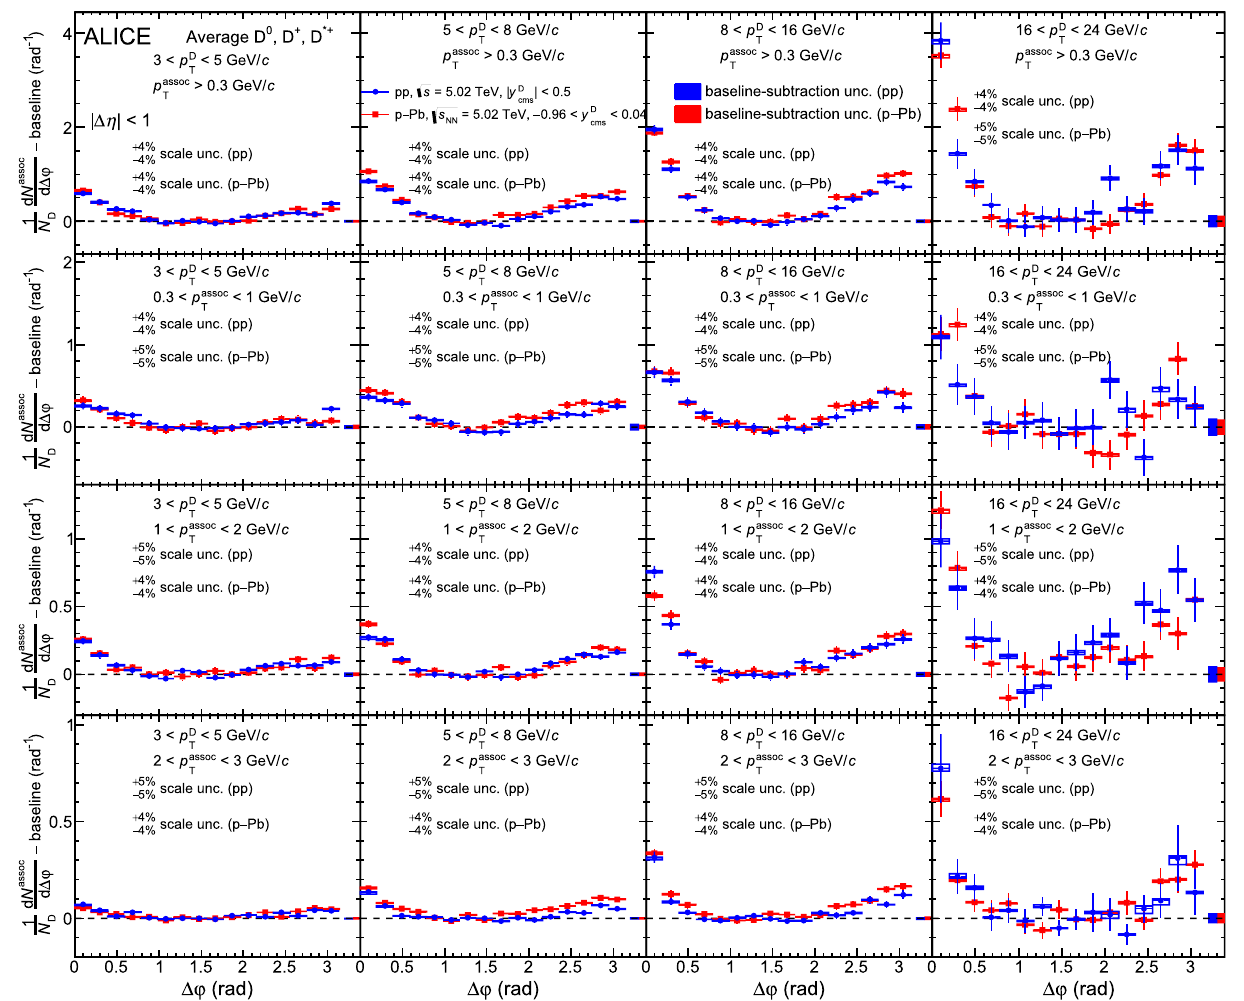
< 3 GeV / c (from top to bottom). Statistical and (cid:4)ϕ - Fig. 3 Average of the azimuthal-correlation functions of D 0 , D + , and and 2 < p assoc T D ∗+ mesons with associated particles, after the subtraction of the dependent systematic uncertainties are shown as vertical error bars and √ s = 5 . 02 TeV and p–Pb collisions at √ boxes, respectively, (cid:4)ϕ -independent uncertainties are written as text. baseline, in pp collisions at < 5 GeV / c , 5 < p D < 8 GeV / c , s NN = 5 . 02 TeV, for 3 < p D The uncertainties from the subtraction of the baseline are displayed as T T < 16GeV / c ,and16 < p D < 24GeV / c (fromlefttoright)and boxes at (cid:4)ϕ > 8 < p D T T > 0 . 3 GeV / c , 0 . 3 < p assoc < 1 GeV / c , 1 < p assoc < 2 GeV / c , p assoc T T T